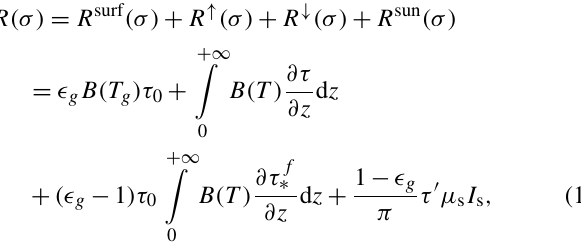
Figure 1. Layering scheme of the atmosphere, with layer number- ing and the definition of